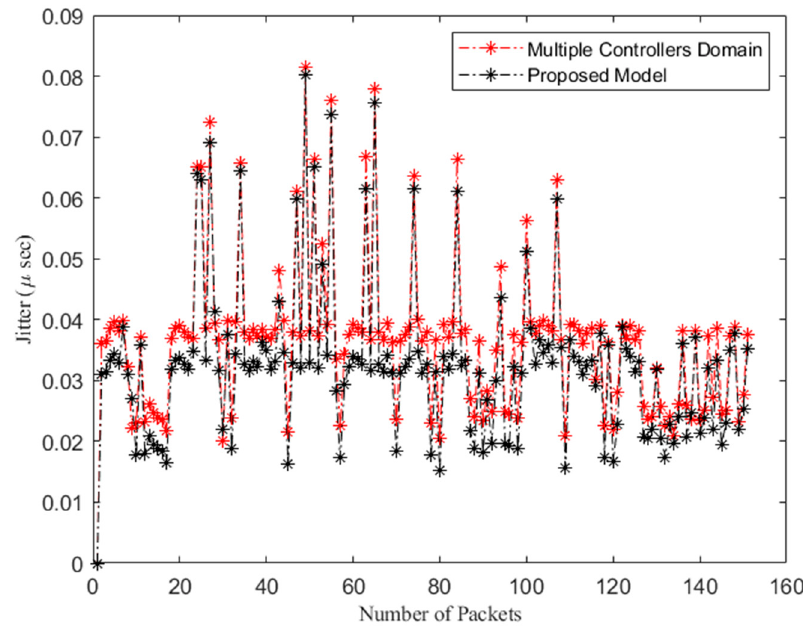
Figure 11. Jitter (packet delay variations) comparison of proposed architecture.